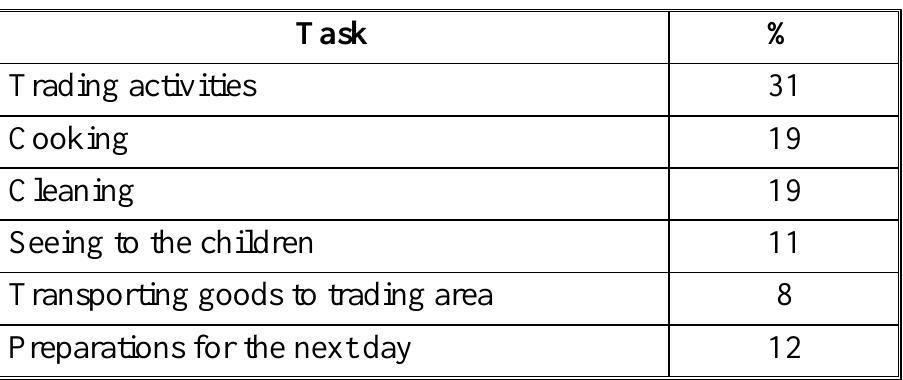
Division of tasks Task